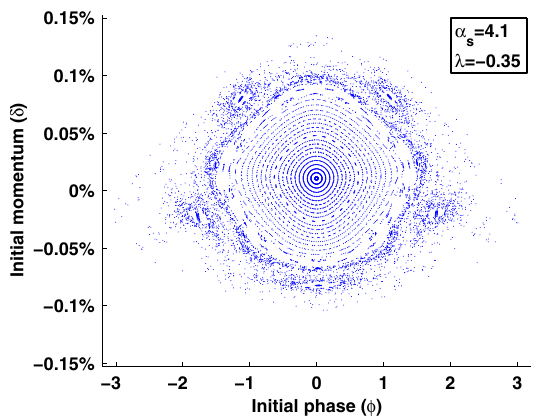
FIG. 11. The 99% admittance at 99% efficiency (at an optimal α λ ) as a function of aspect ratio. The solid double lines s and indicate the admittance for harmonic slip stacking constrained to 100 kV main rf voltage and 20 kV harmonic rf voltage. The dashed double lines indicate admittance for unconstrained rf